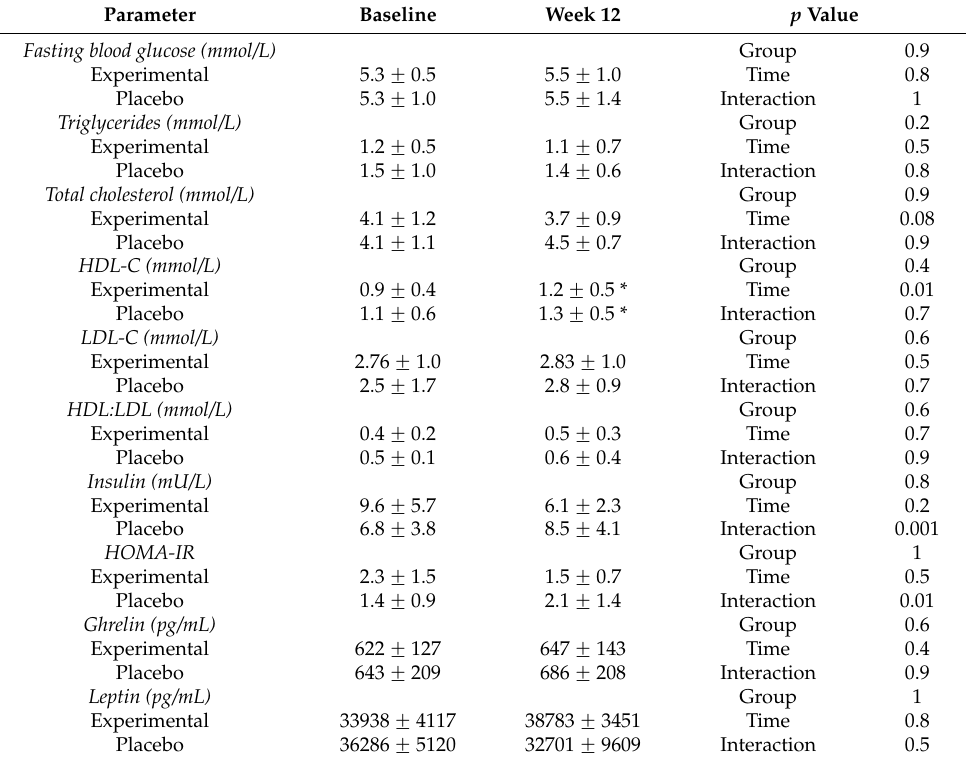
Table 3. Metabolic parameters of participants at baseline and week 12 of intervention with C . forskohlii extract ( n = 15 in each group).